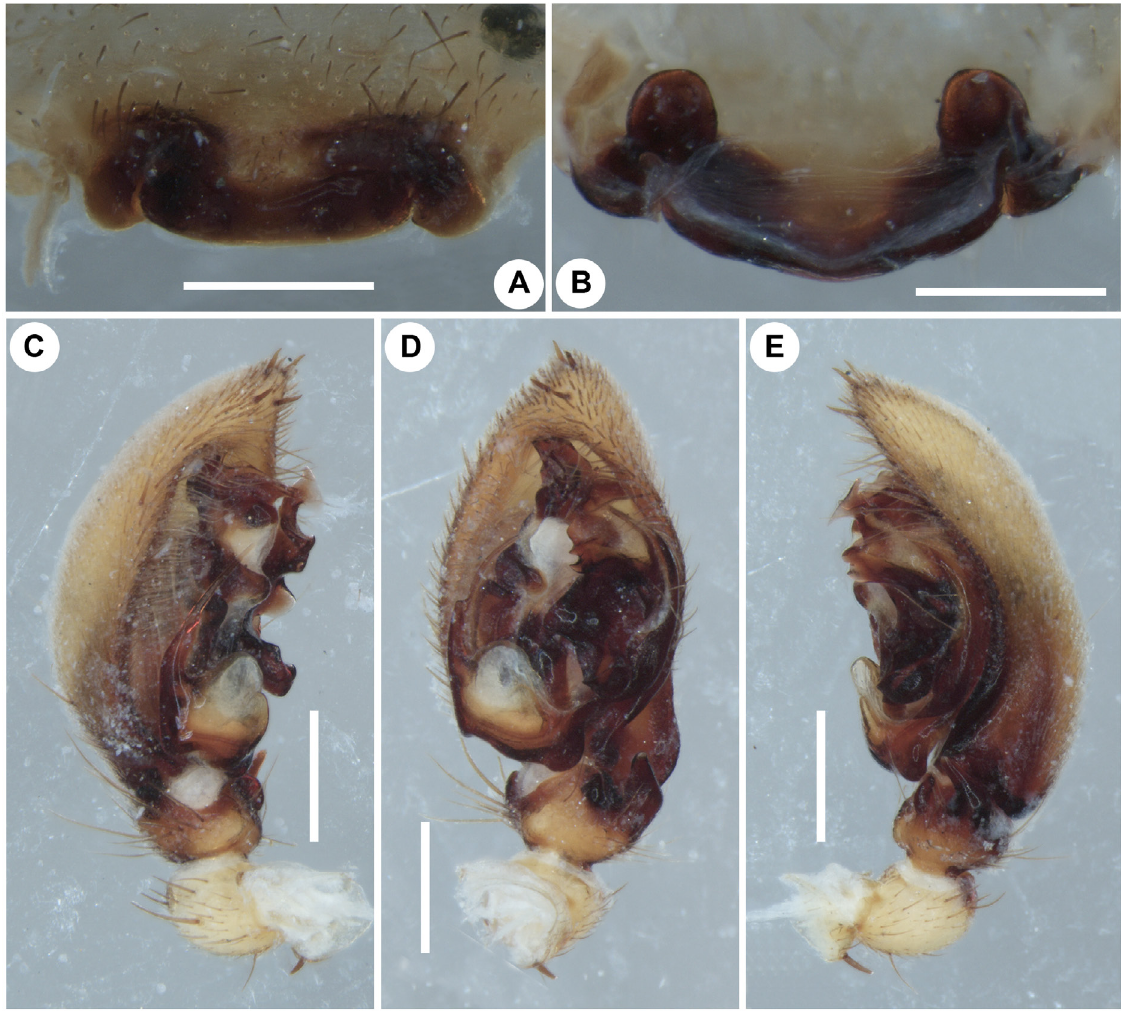
Fig. 11. Mallinella indica (Tikader & Patel, 1975) comb. nov., ♂♀, paratype and allotype of Storena indica Tikader & Patel, 1975. A – B . Genitalia of paratype, ♀ (NZC-ZSI-5355/18). A . Epigynum, ventral view. B . Vulva, dorsal view. C – E . Left pedipalp of allotype, ♂ (NZC-ZSI-5356/18). C . Prolateral view. D . Ventral view. E . Retrolateral view. Scale bars: A–B = 0.2 mm; C–E = 0.5